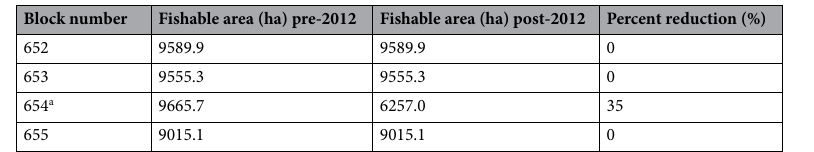
Table 1. The fishable area of state waters within the CDFW fishing blocks off the coast of Santa Barbara before and after the establishment of MPAs in 2012. a Denotes fishing block with MPAs.